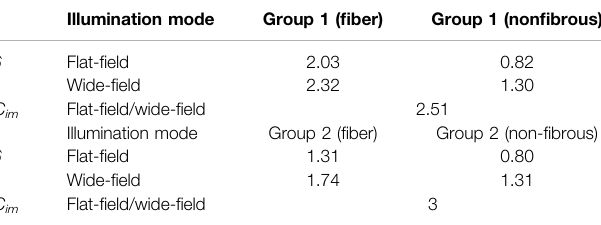
TABLE 2 | Comparison of the FWHM in fi bers and non fi brous tissues. Illumination